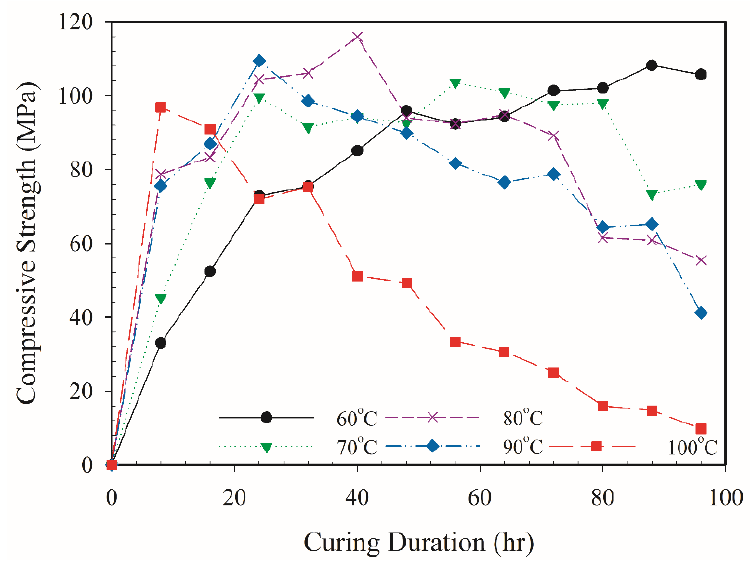
Figure 7. Variations with curing duration in the 4-day compressive strength of geopolymer specimens at various curing temperatures when AE% = 6%.